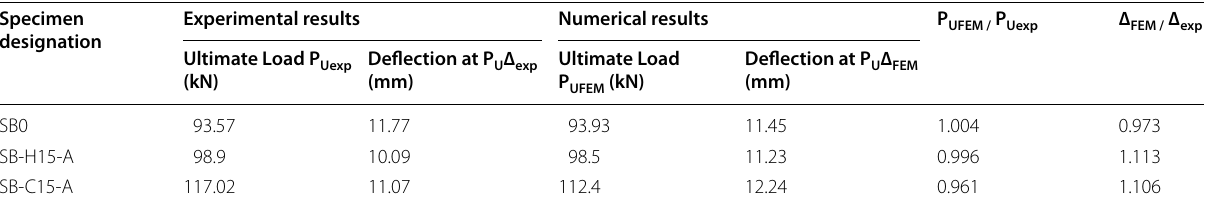
Table 10 Comparison between experimental and numerical